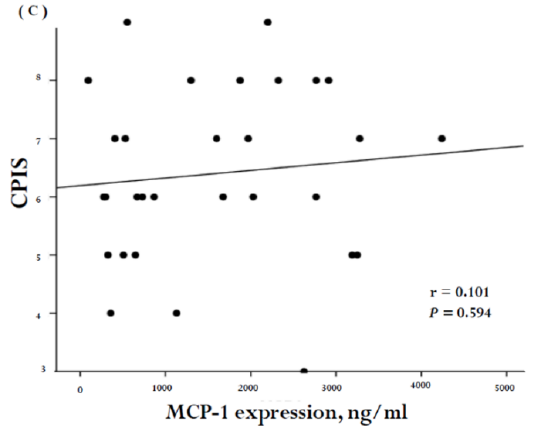
Figure 6. Correlation of plasma MCP-1 levels with severity of organ failure score (specifically for VAP) in 30 VAP subjects. Scoring system developed specifically for VAP, including ( A ) PIRO, ( B ) IBMP-10 concepts, and ( C ) CPIS. There was a significant correlation between MCP-1 levels and PIRO score (general linear model, r = 0.494, p = 0.005, n = 30) and IBMP score (general linear model, r = 0.514, p = 0.004, n = 30).